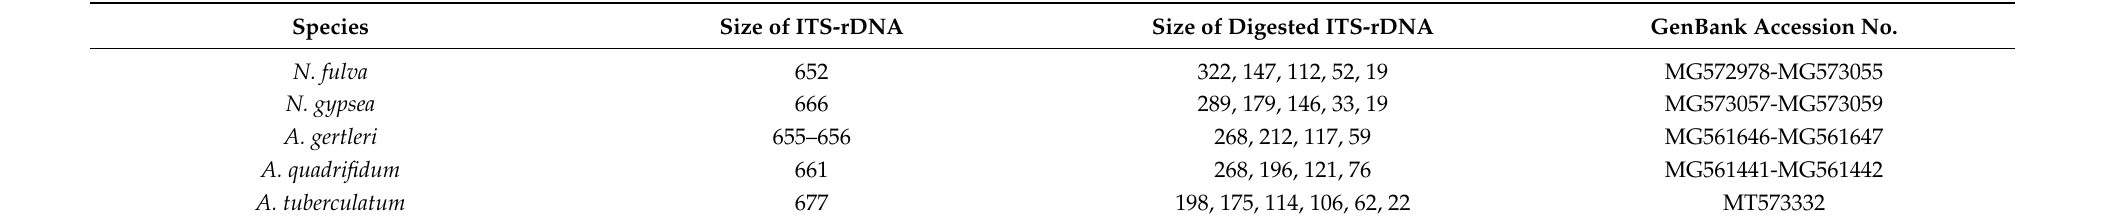
Table 2. ITS-RFLP profiles of the keratinophilic fungi identified in this study.